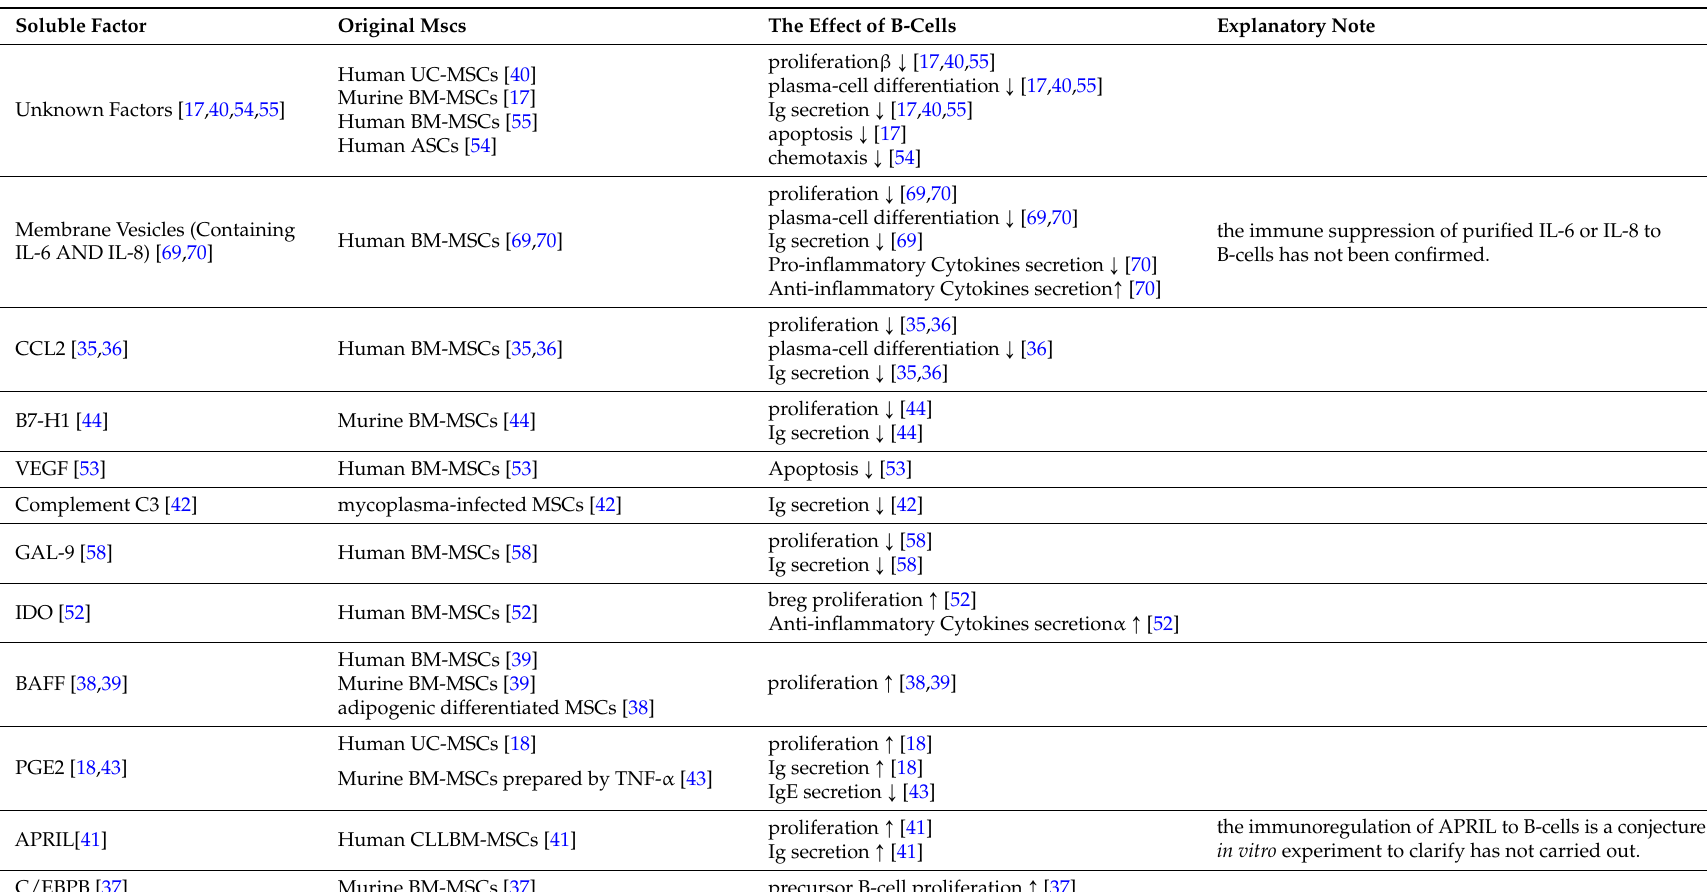
Table 1. Soluble factors related to the interaction between MSCs and B